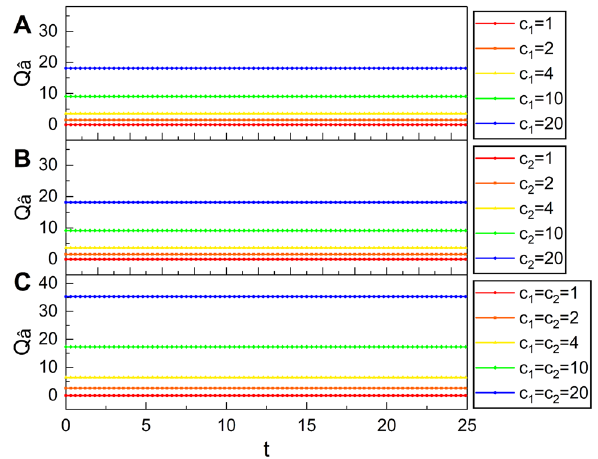
Figure 7. Mandel’s parameter Q 1 for A, c 1 used c 2 =